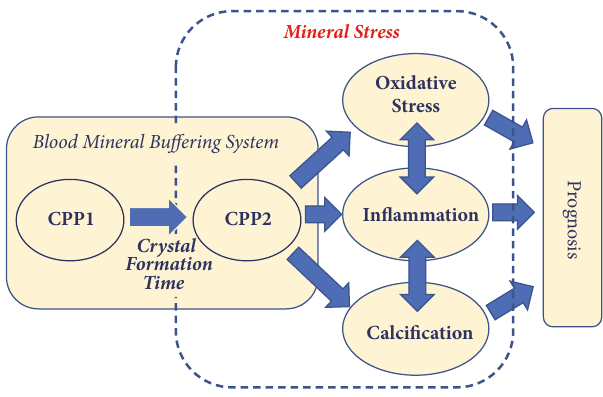
Figure 1: Schematic illustration of the Mineral Stress hypothesis. Mineral Stress is caused by excess calciprotein particles, which upon interactionwith susceptible cells, tissues, and organs induce damage in the form of oxidative stress, inflammation, and calcification. These clinical problems then contribute to adverse outcome. CPP are formed by the blood mineral buffering system when calcium andphosphateconcentrationsareraised.PrimaryCPP(CPP1)occur earlier during excess mineral buffering, whereas CPP2 should not occur in sizeable amounts, because CPP in general are rapidly cleared from circulation. Longer crystal formation time in vitro has consistently been associated with better cardiovascularoutcome in multiple clinical studies. Figure provided with courtesy from Calciscon AG.